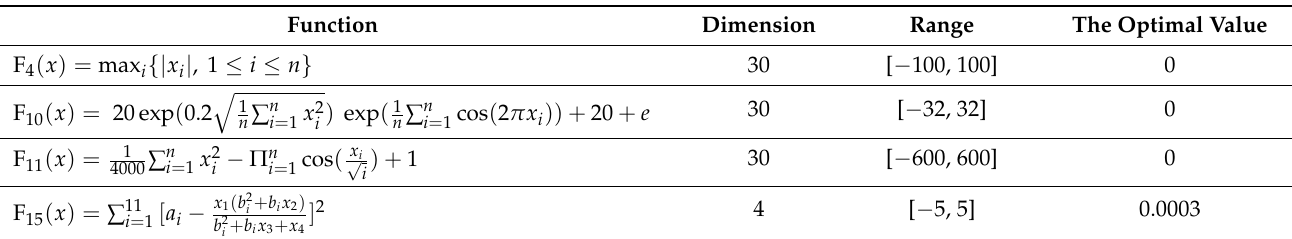
Table 1. Benchmark